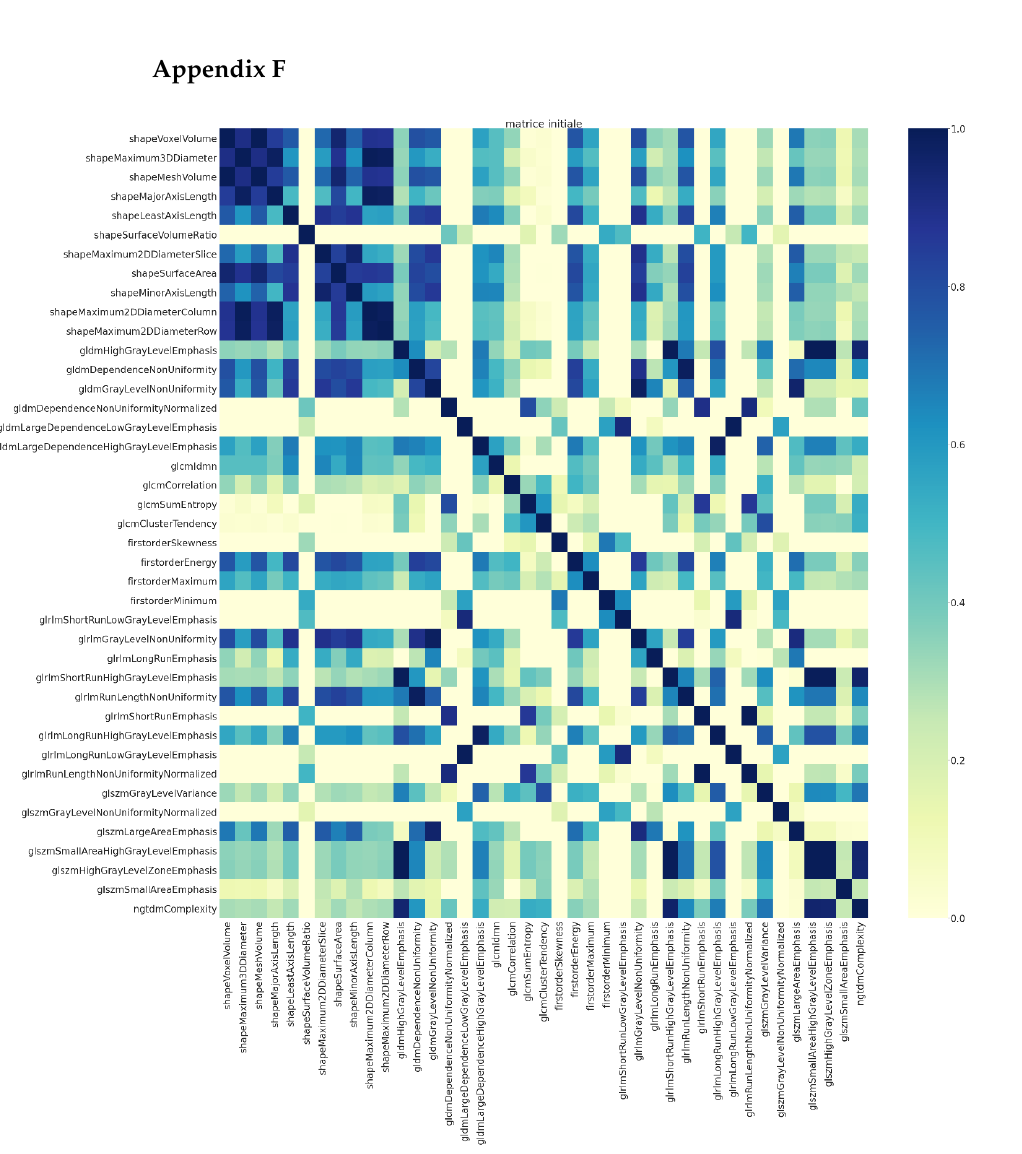
Table A6. Hyperparamter bounds for Bayesian optimization.